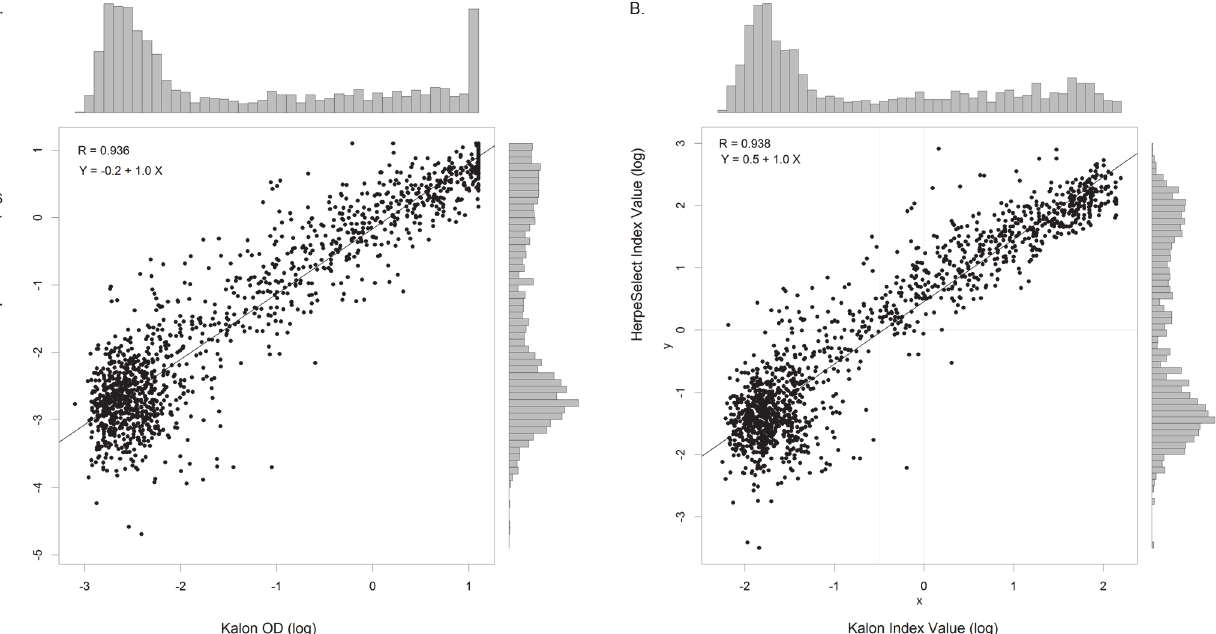
Fig 1. HerpeSelect vs Kalon assay results: a. optical densities (log), b. index values (log). Bold black line represents a linear regression line of Y (HerpeSelect result) in function of X (Kalon result). Full grey lines in panel b. represent theoretical cut-off of and index value of 1.00 for Kalon and HerpeSelect. The dotted line represents the lowered cut-off for the index value of Kalon at 0.60. Points in the upper right and lower left quadrant are concordant results, point in the upper left and lower right quadrant are discordant results at the respective cut-offs.